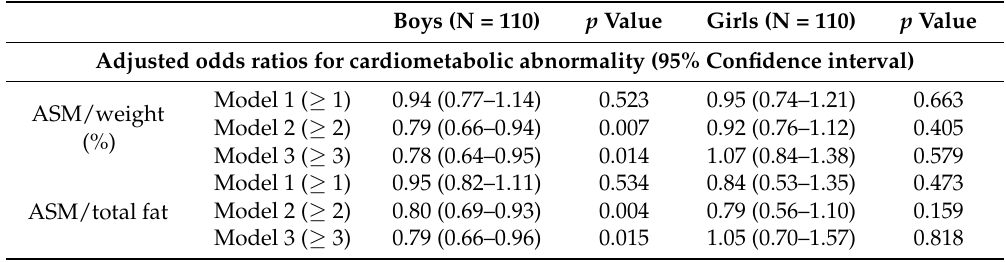
Table 2. Association between skeletal muscle mass and risk of being metabolically unhealthy in overweight/obese adolescents. Boys (N = 110) p Value Girls (N = 110) p Value Adjusted odds ratios for cardiometabolic abnormality (95% Confidence